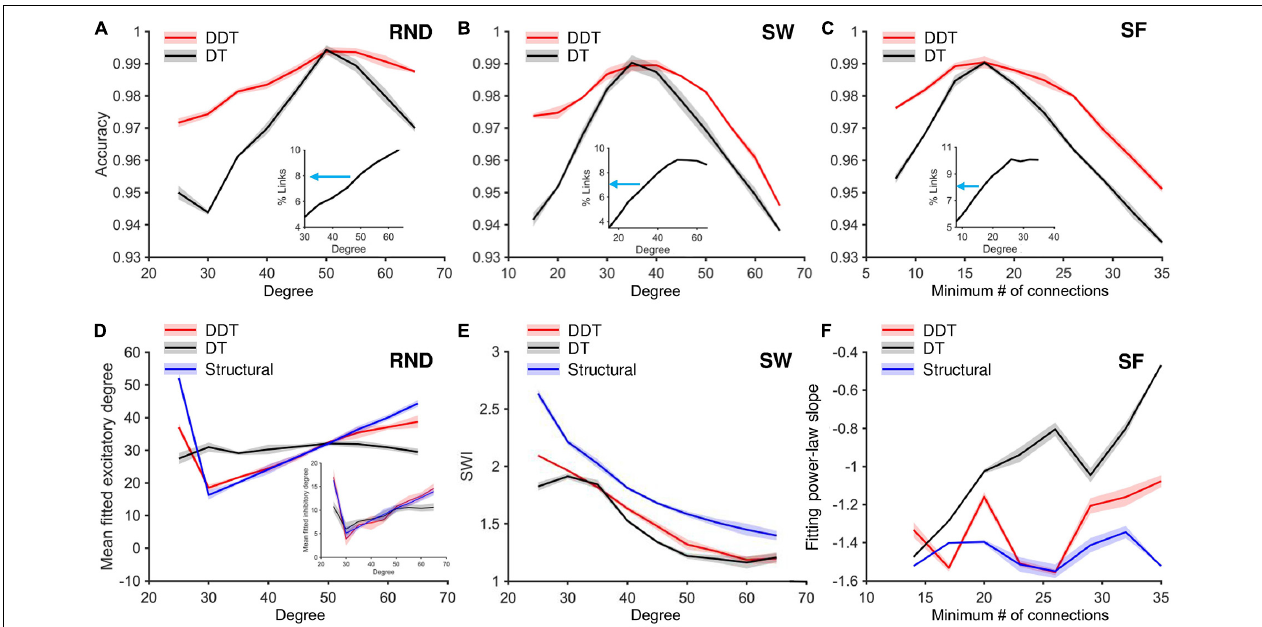
FIGURE 6 | Accuracy analysis of DDT and DT algorithms by sweeping the mean degree of RND and SW networks, and the minimum number of connections for SF networks. (A–C) The trend of the link classification accuracy values in RND, SW, and SF matrices, respectively, calculated by applying the DDT (red line) and DT (black line) methods. For each value of k , three networks were simulated, for each of the different topologies. In each of these panels, the trend of the density of the structural networks (in the form of percentages of links actually existing in the network with respect to the total possible number of connections) is represented as an inset, increasing the average degree k in the RND and SW networks, the minimum number of connections k for each neuron in the SF networks. The blue arrows indicate the median value of the density curve, which is used to define the M i and M e parameters by applying the DT method. (D) Mean value of the fitted excitatory normal degree distribution computed across all networks by varying the structural degree k , comparing networks thresholded with DDT (red line), DT (black line), and the structural target (blue line). The inset shows the fitted inhibitory degree. (E) SWI of SW networks by varying the structural degree k , comparing networks thresholded with DDT (red line), those with DT (black line), and the structural target (blue line). (F) Slope of the fitted total (i.e., both excitatory and inhibitory links) power-law degree distribution computed across all networks by varying the structural degree k , comparing networks thresholded with DDT (red line), those with DT (black line), and the structural target (blue